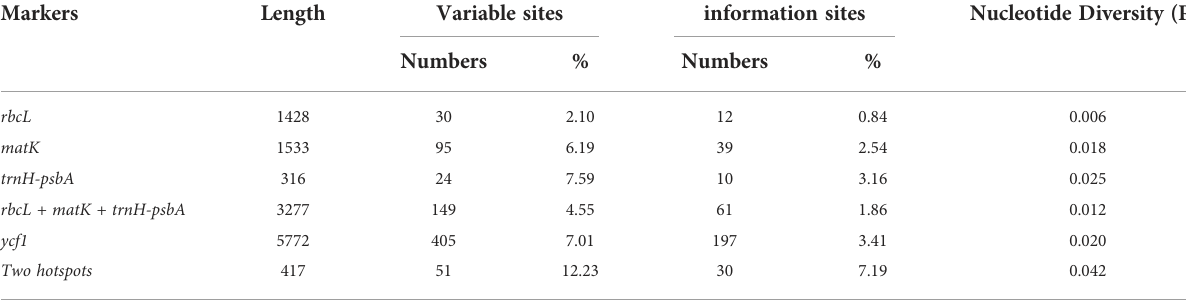
TABLE 1 The variability of the hypervariable markers and universal DNA barcodes. Markers Length Variable sites information sites Nucleotide Diversity (Pi) Numbers %